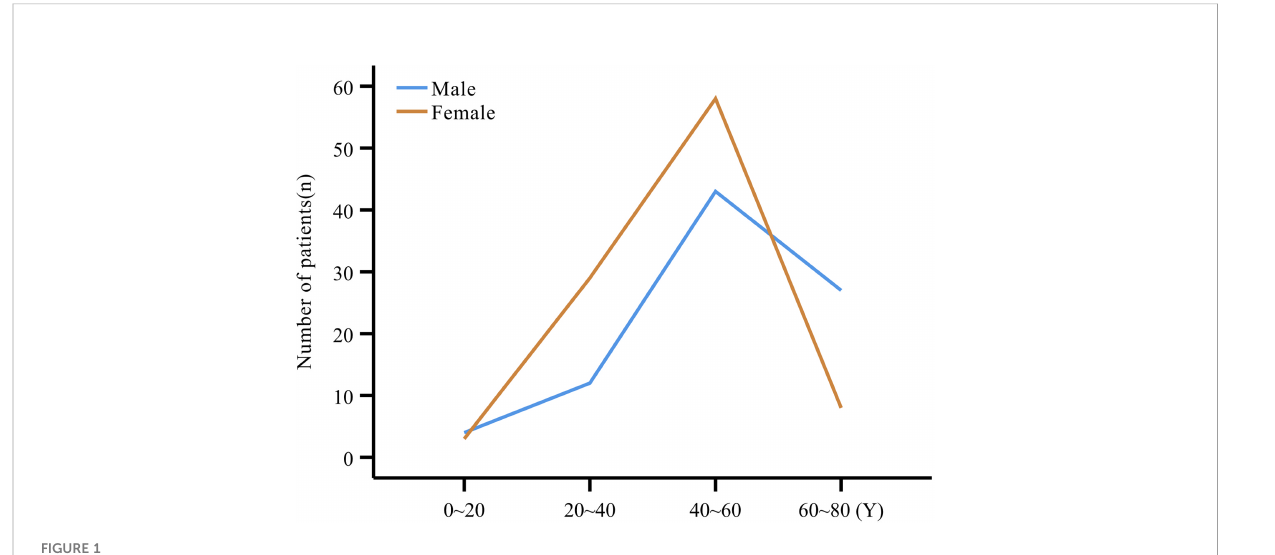
FIGURE 1 Number of males and females in each age